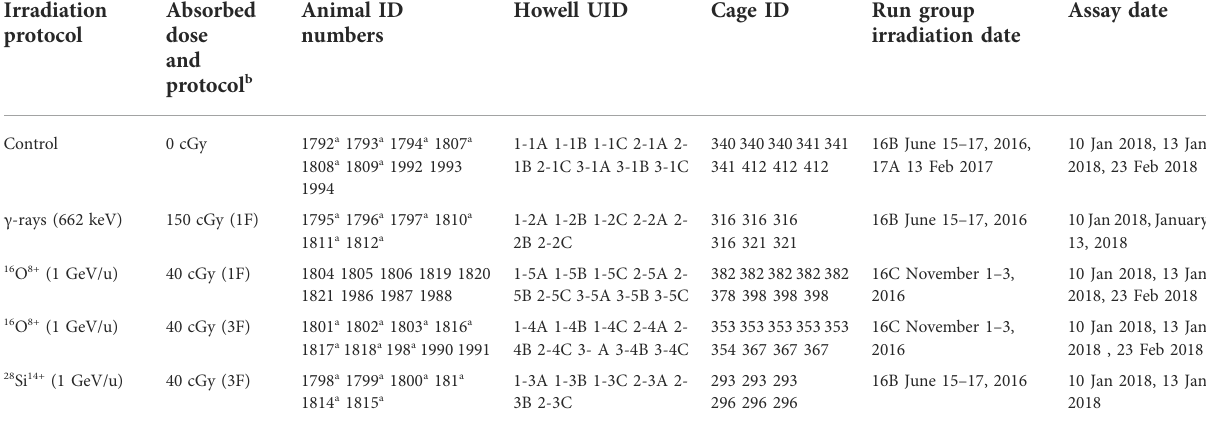
TABLE 1 Animal groups, absorbed doses and irradiation